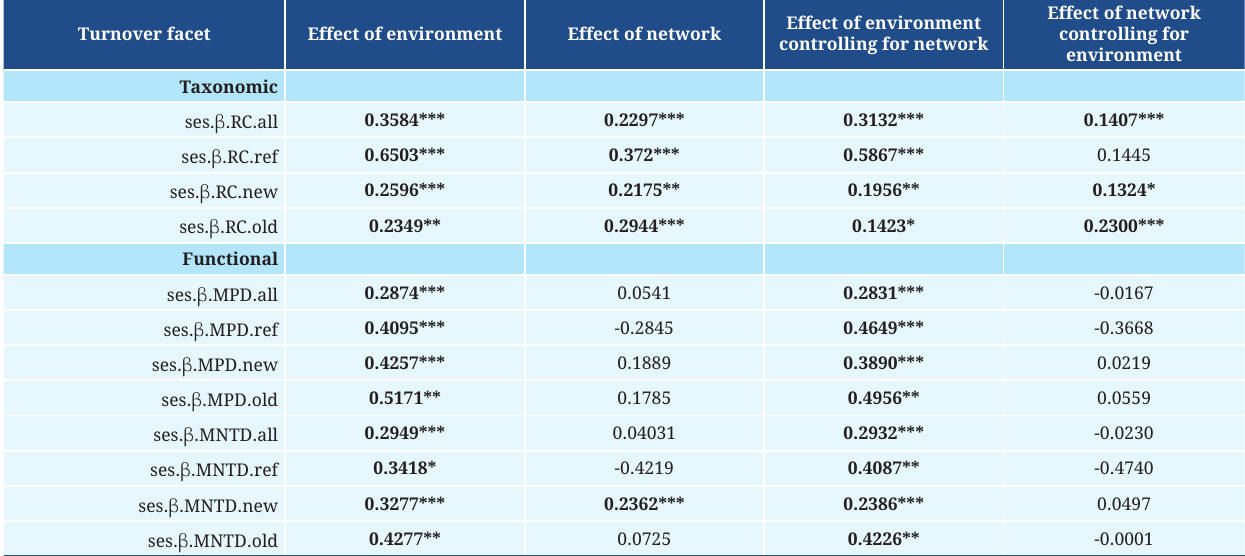
TABLE 4 | Mantel and partial Mantel tests for the correlation between standardized effect size (ses) of turnover metrics and predictor distances (environment and network) using Pearson’s correlation (ρ ), with 10,000 permutations. Significant values in bold: *** P < 0.001; ** P < 0.01; * P <